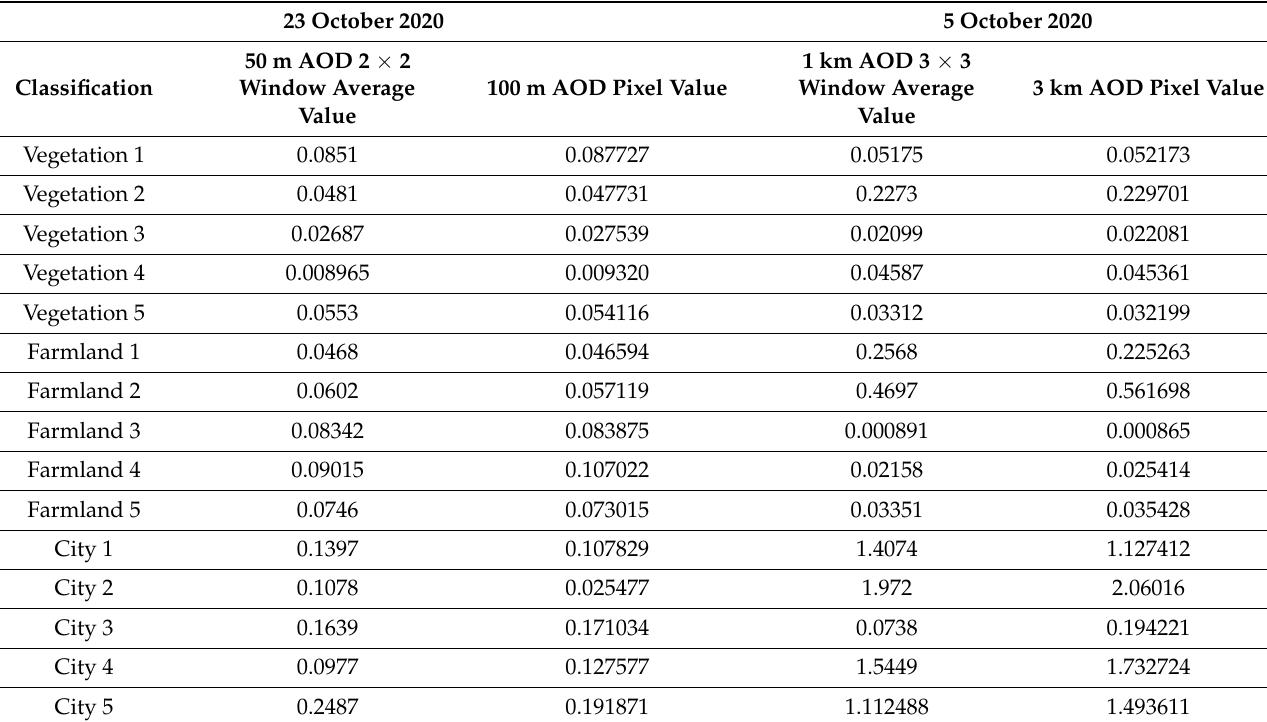
Figure 9. Correlation analysis of vegetation, farmland and city in 10 km and 1 km AOD results: ( a – c ) are the correlation analysis of 10 km and 1 km AOD results for vegetation, farmland, and city areas, respectively. Table 4. The 50 m AOD 2 × 2 window average value and corresponding 100 m pixel value of typical vegetation, farmland and city single pixels on 23 October 2020 and the 1 km AOD 3 × 3 window average value and corresponding 3 km pixel value of typical vegetation, farmland and city single pixels on 5 October